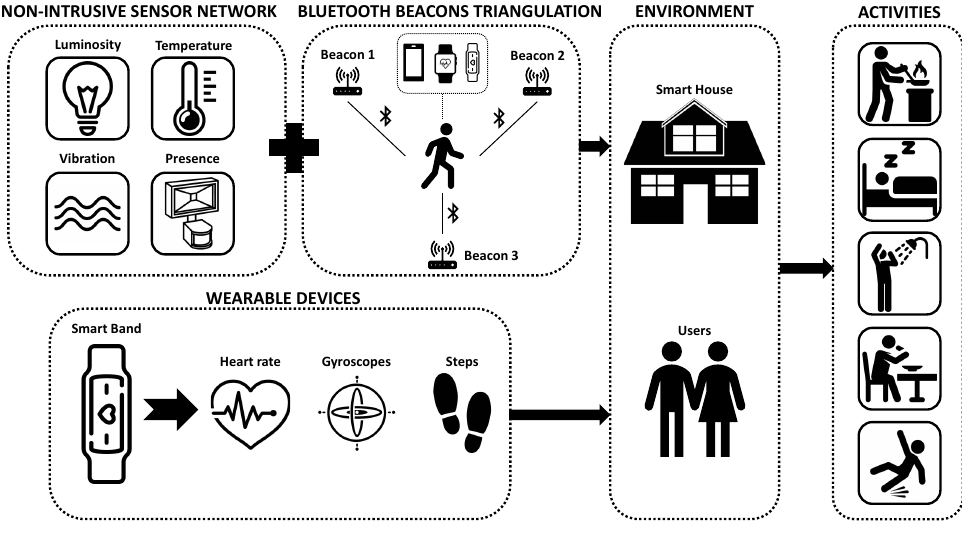
Figure 1. General diagram of the components of the non-intrusive monitoring